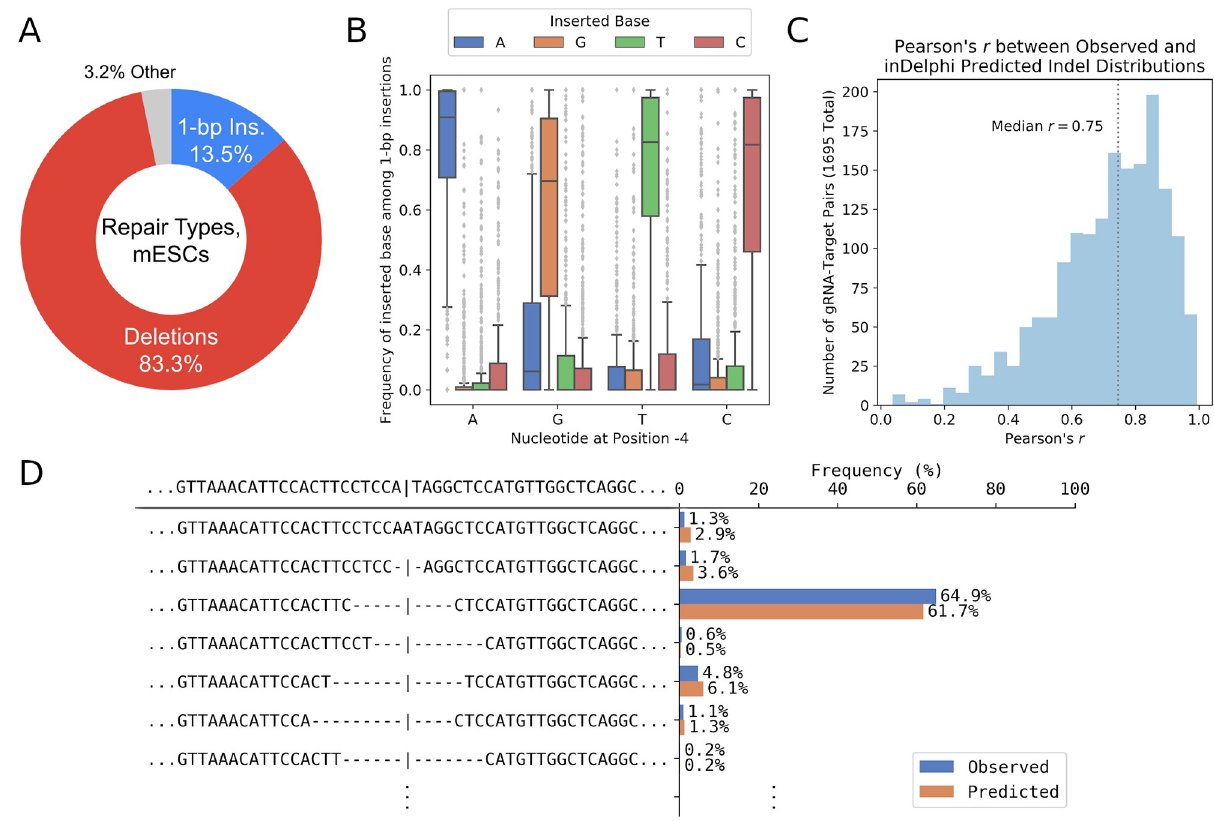
Fig 2. inDelphi accurately predicts editing outcomes. (A) The categories of editing products at 1,549 lib-SA target sites in mESCs. “Other” denotes products such as multiple base pair insertions and combination indels. (B) 1-bp insertion frequencies among 1,549 lib-SA target sites, compared to the − 4 nucleotide from their NGG PAM. (C) The distribution of Pearson’s r between observed and inDelphi predicted repair genotype frequencies for 1,695 gRNA lib-SA target pairs. (D) An example distribution of observed and inDelphi predicted repair genotype frequencies ( r = 0.98) for a particular gRNA lib-SA target pair (S1 Table, Identifier number